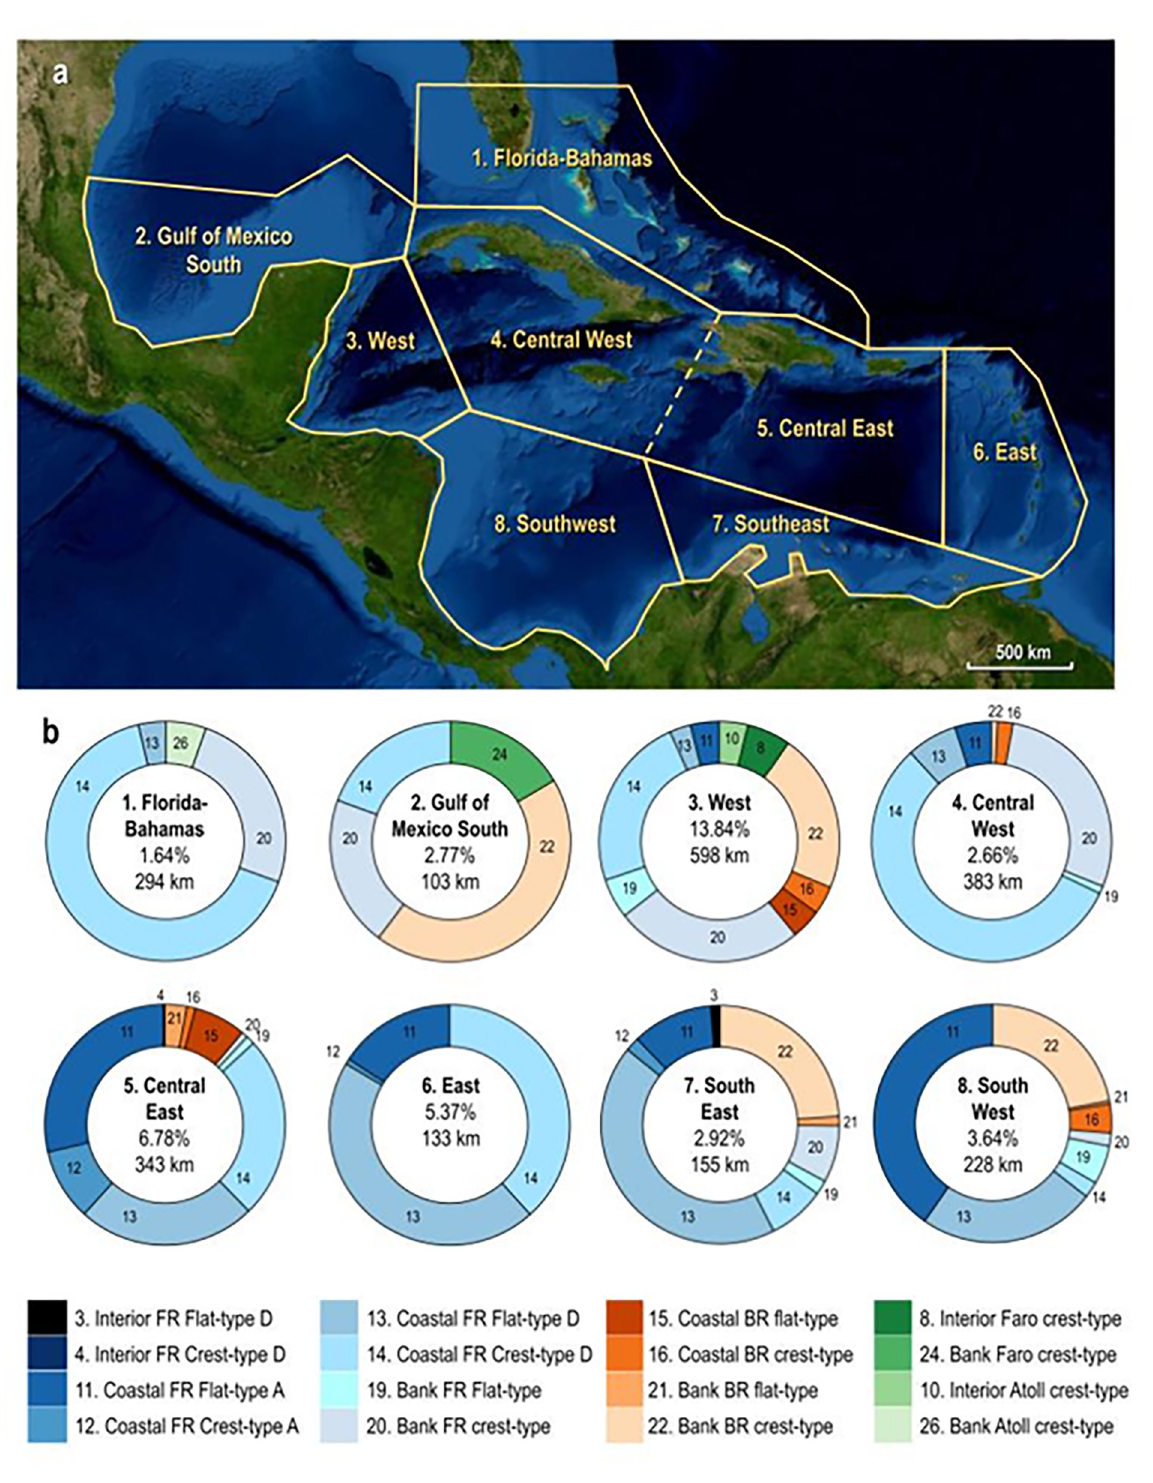
Fig 3. Distribution of breakwater reef subtypes in 8 ecoregions of the Greater Caribbean. a. Ecoregions, including the Gulf of Mexico South, Florida-Bahamas, and the West, East, Central (divided into Central East and Central West), Southeast, and Southwest Caribbean (modified after Spalding et al. 2007). b. Reef subtypes in each ecoregion, showing the total length of breakwater reefs (km), and their relative abundance considering the total coastal length (%). Note a bipartite distribution, with flat-type coastal reefs (11 and 13) dominating the Central East, East,